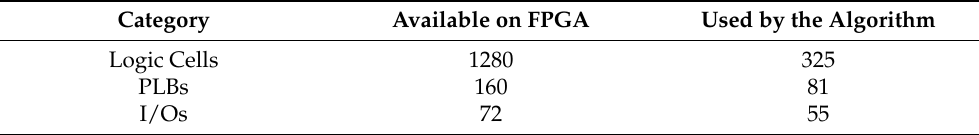
Table 5. FPGA usage summary.